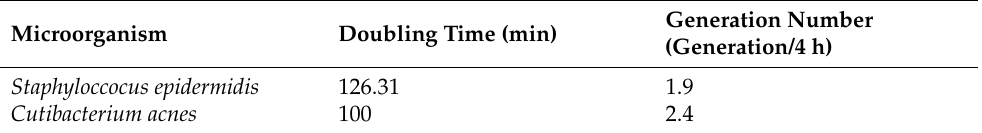
Table 2. Kinetic parameters of growth of Staphyloccocus epidermidis and Cutibacterium acnes .